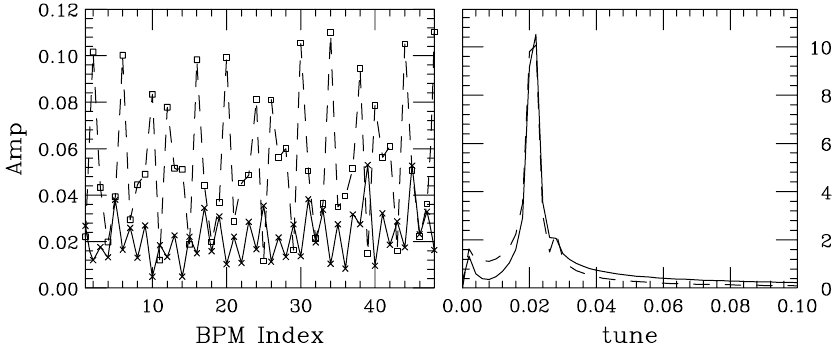
(cid:4) 2 (cid:30) (cid:15) 1 (cid:3) 0 in tracking data (500 turns) of the booster. The tune of FIG. 6. Third order resonance signals corresponding to (cid:15) (cid:30) x z (cid:3) 6 : 657 53 , (cid:30) (cid:3) 6 : 839 29 . The currents in sextupole families are ISEXTL (cid:3) 20A , ISEXTS (cid:3) 5A . the signals is 0 : 021 07 , while (cid:30) x z Left plot: Amplitude of the resonance signal at horizontal (solid cross) and vertical (dash square) BPMs. Right plot: the FFT spectrum of the two resonance